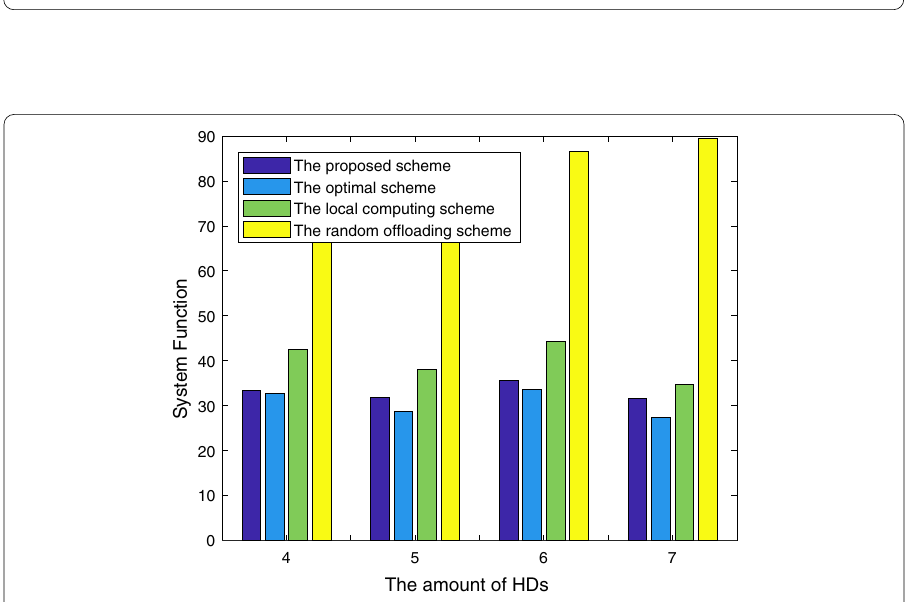
Fig. 7 The value of the system function of different schemes versus the number of HDs (the simulation parameters of the network and the device are different in different